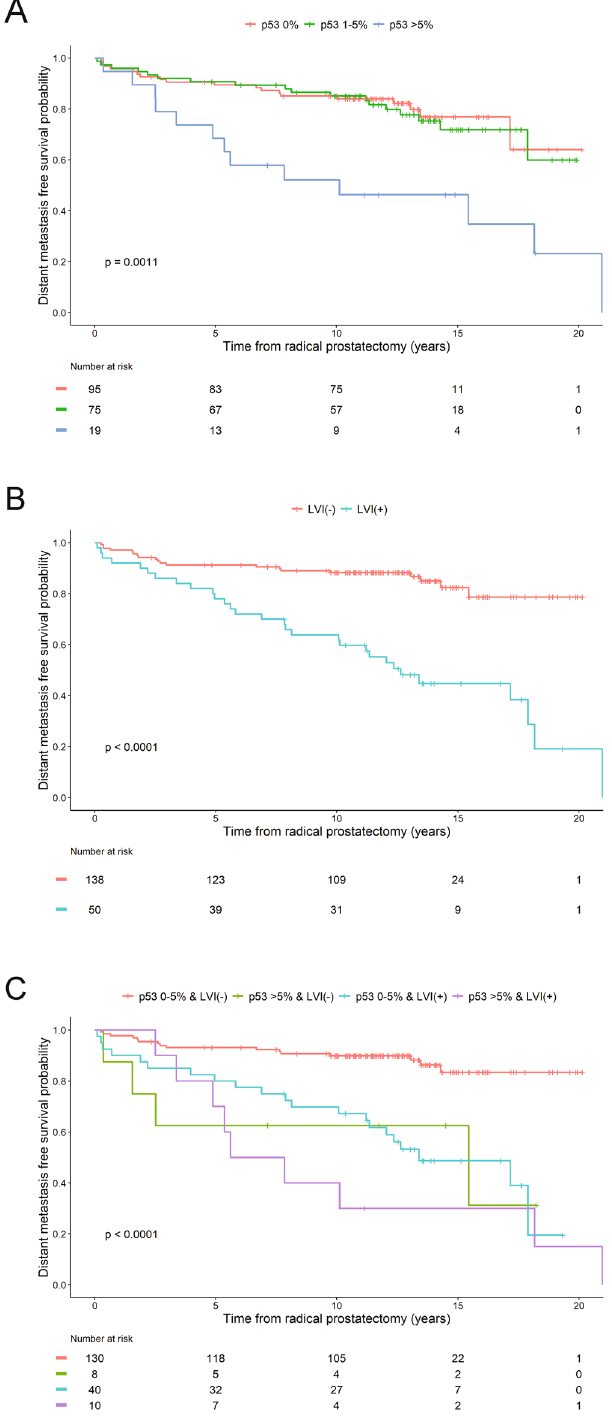
Figure 3. Product limit estimates for p53 and LVI with distant metastasis-free survival as endpoint events. Unadjusted Kaplan–Meier estimation curves showing models of time from surgery to DM-free survival as a function of p53 expression ( A ), LVI status ( B ), and combined p53 expression and LVI status ( C ), in index tumors as key independent study predictors for all patients (N =